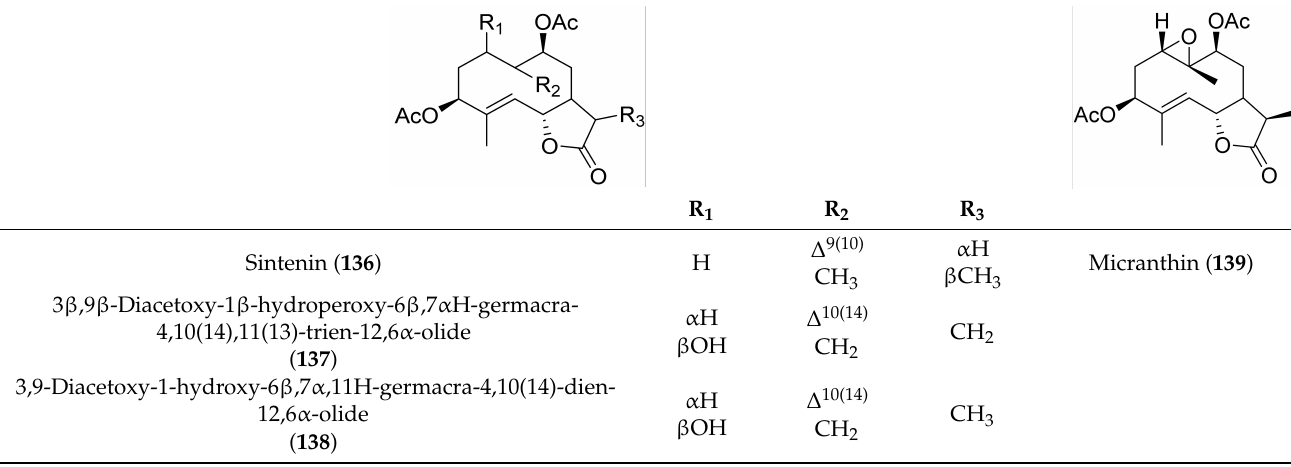
Table 12. Chemical structures of germacranolides from Achillea